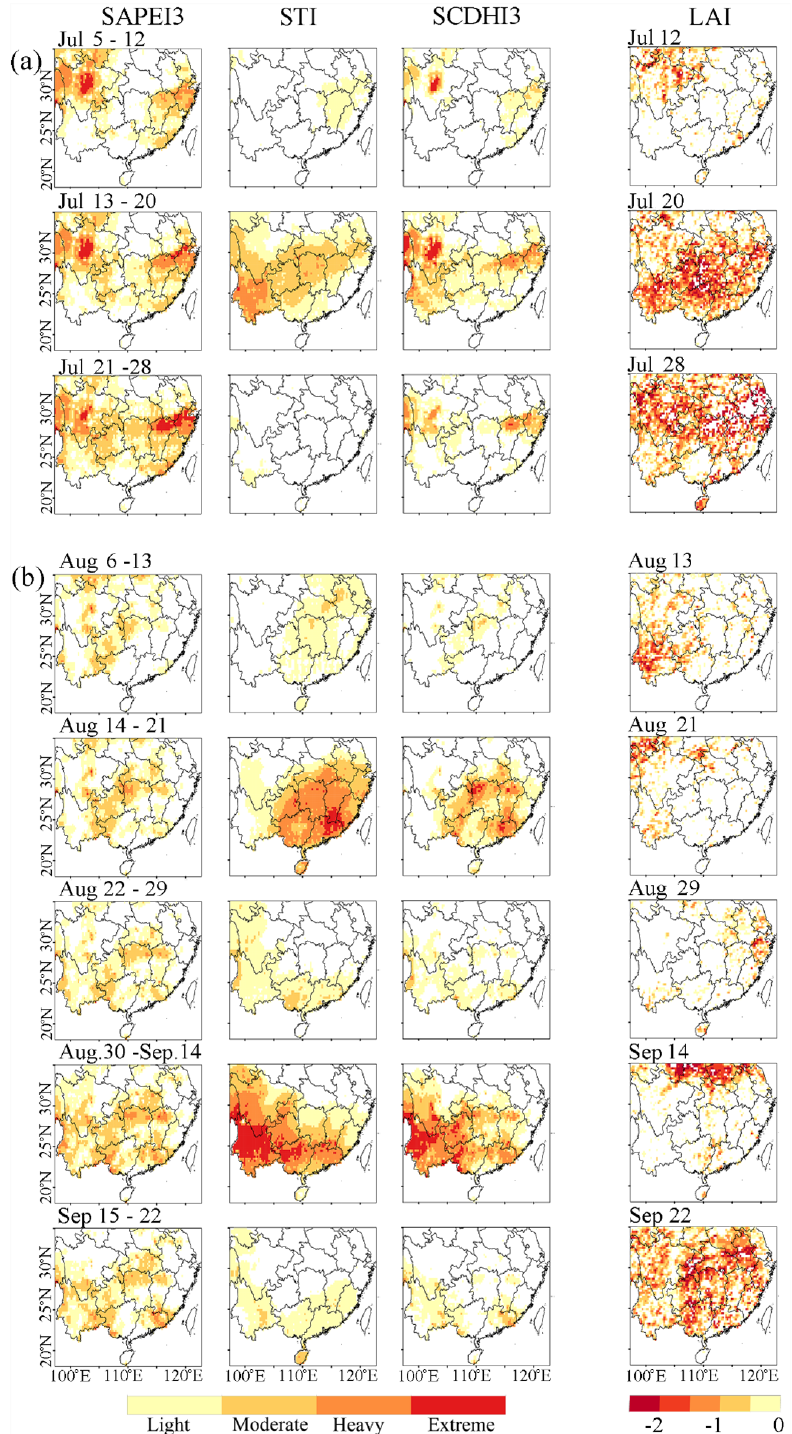
Figure 9. The spatial evolutions of the compound dry and hot event over southern China in 2009 and its impact on vegetation as weekly